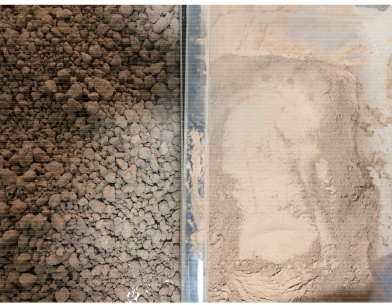
Figure 1. Original mud consolidated soil sample.